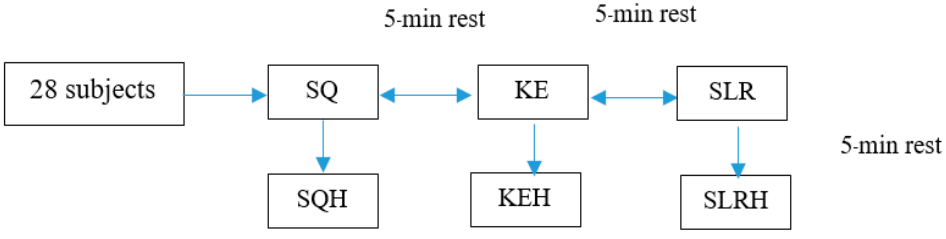
Figure 1. Steps of performing each exercise.